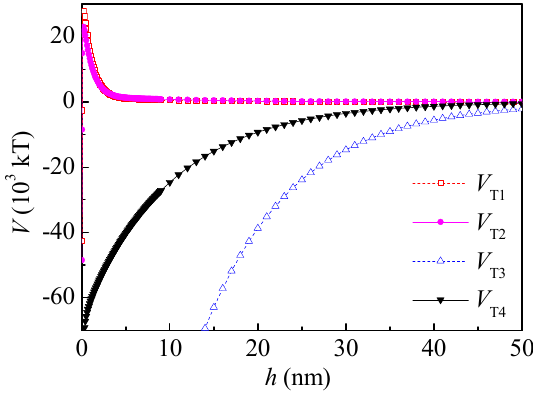
Figure 7. Total potential energy before and after adsorbed PAM A401. V T1 is the total potential energy between coal particles; V T2 is the total potential energy between coal particles after adsorption of PAM A401; V T3 is the total potential energy between kaolinite and coal particles; V T4 is the total potential energy between kaolinite and coal particles after adsorption of PAM A401.